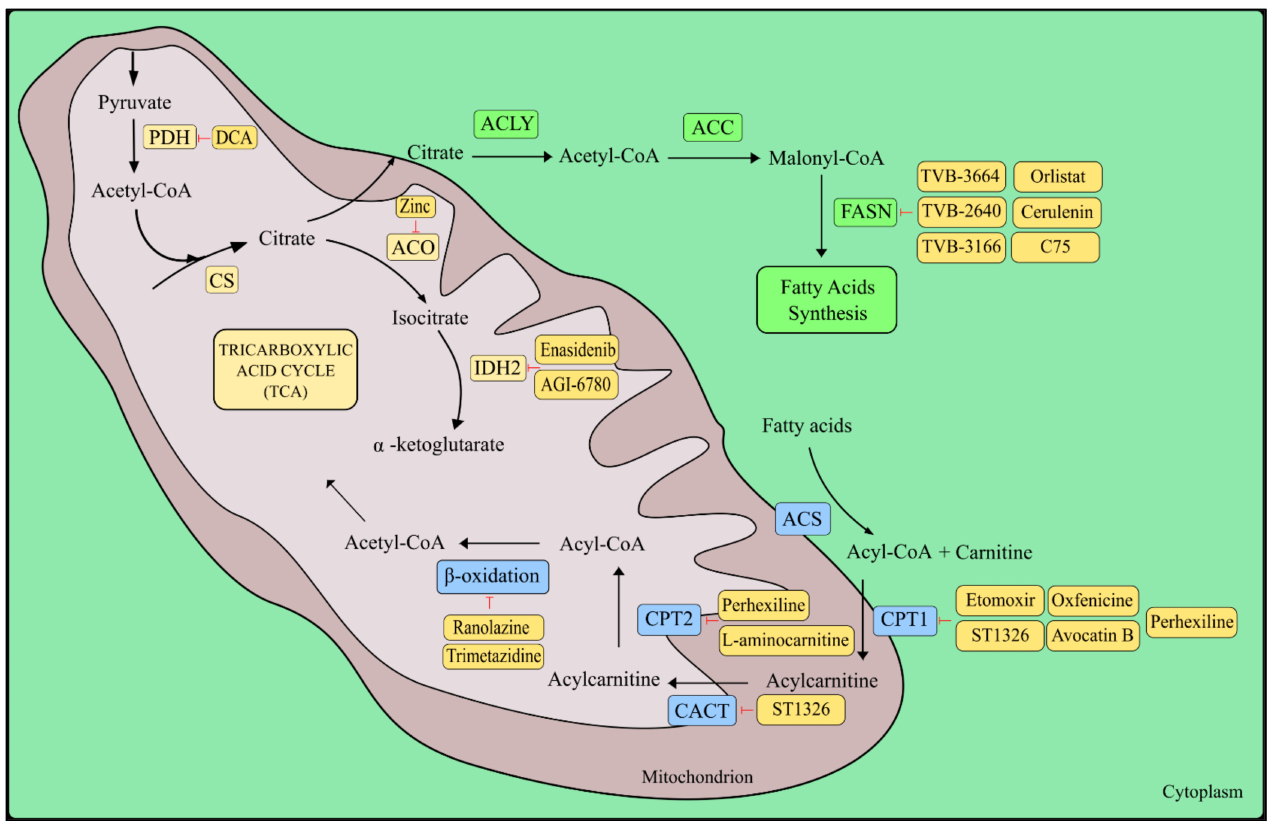
Figure 3. Graphical representation of pyruvate dehydrogenase complex (PDH), aconitase (ACO), isocitrate dehydrogenase 2 (IDH2), fatty acid synthesis, as well as metabolism inhibitors and